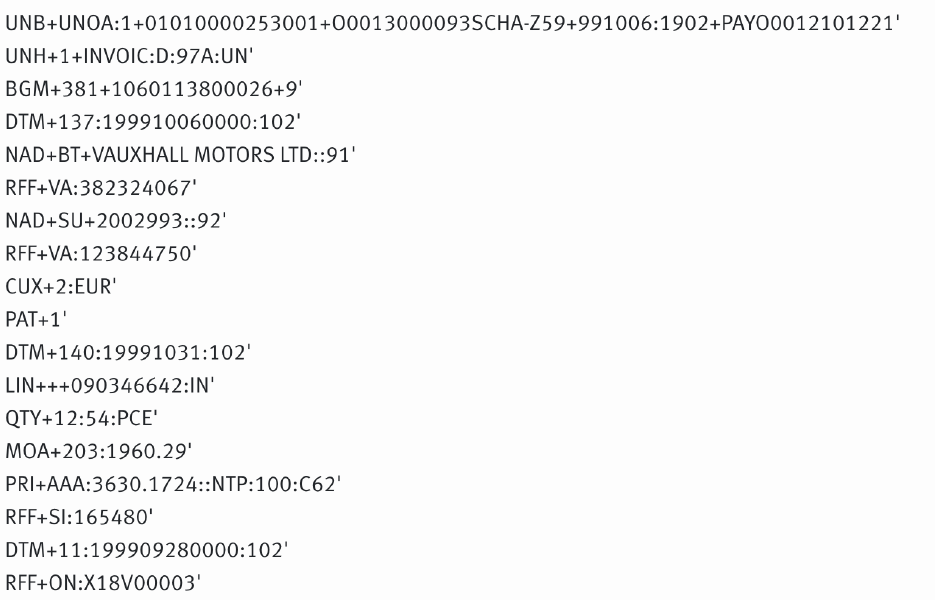
Figure 2. EDIFACT